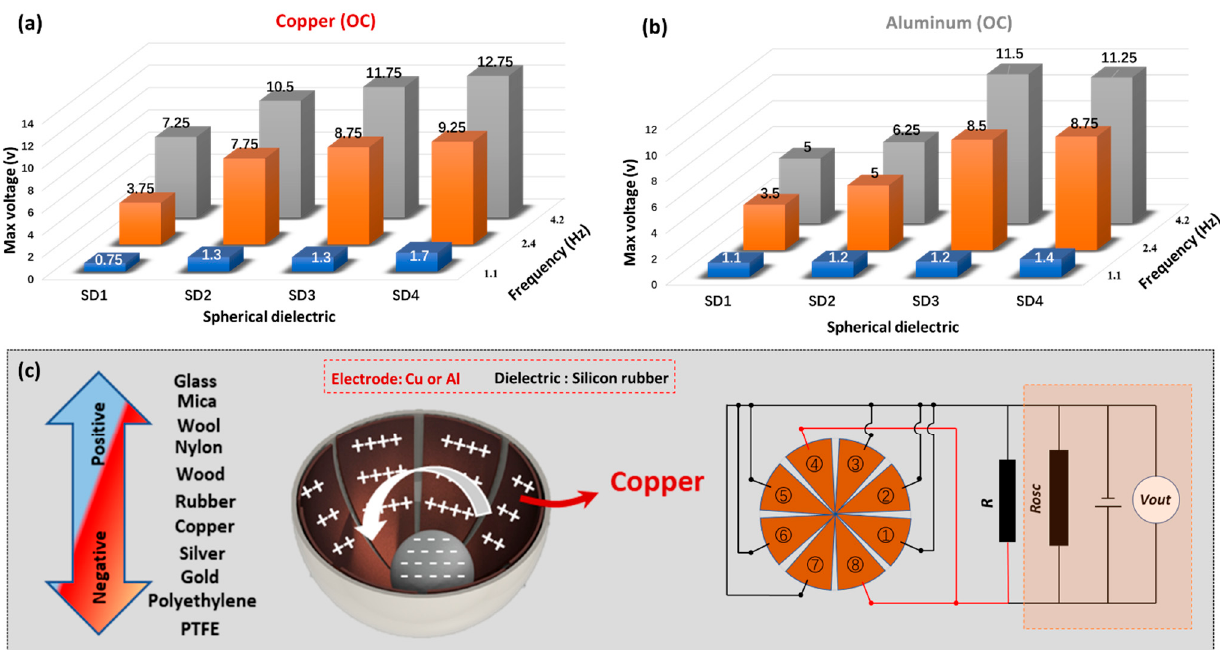
Figure 4. Comparison effect of the frequency performance on the RS-TENG. Comparison of the voltage of ( a ) copper (Cu) and ( b ) aluminum (Al) in SD 1, SD2, SD3 and SD4 with various frequencies; ( c ) series of triboelectric materials [38].